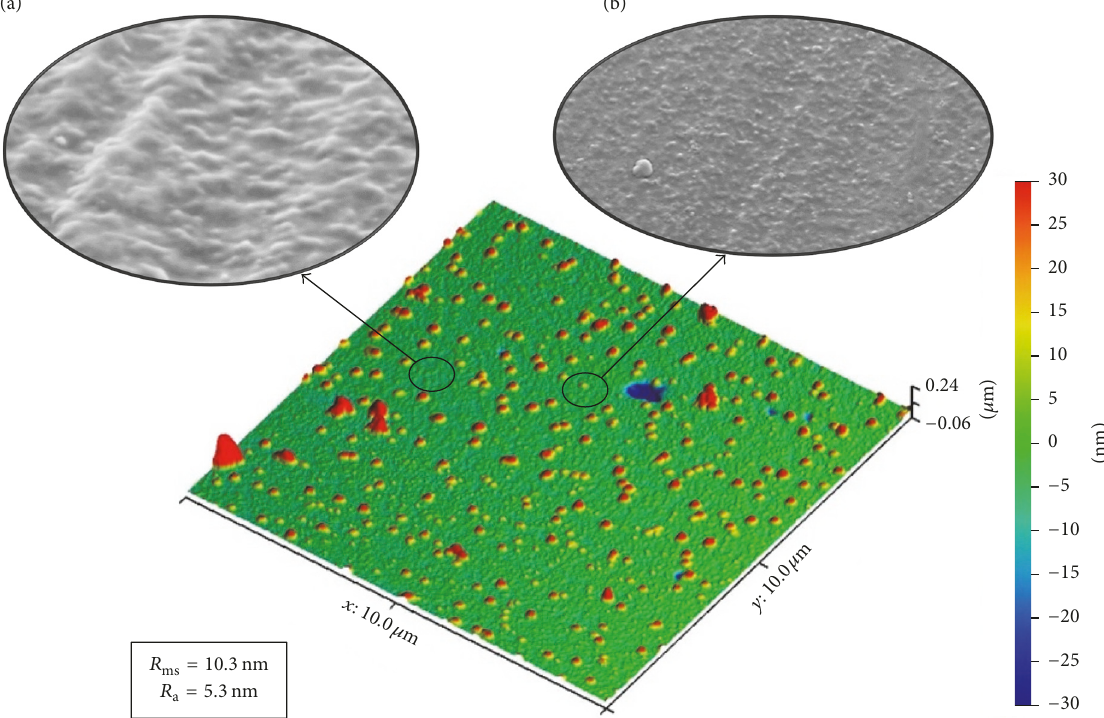
Figure 14: AFM image of the AlTiN coating surface deposited at 100 Hz for a scanned area of 10 × 10 𝜇 m with a maximal structure height of 236 nm and a maximal structure depth of − 60nm. Both SEM images (a) and (b) illustrate the surface structure in the nanometre range as examples for the marked surface areas in different